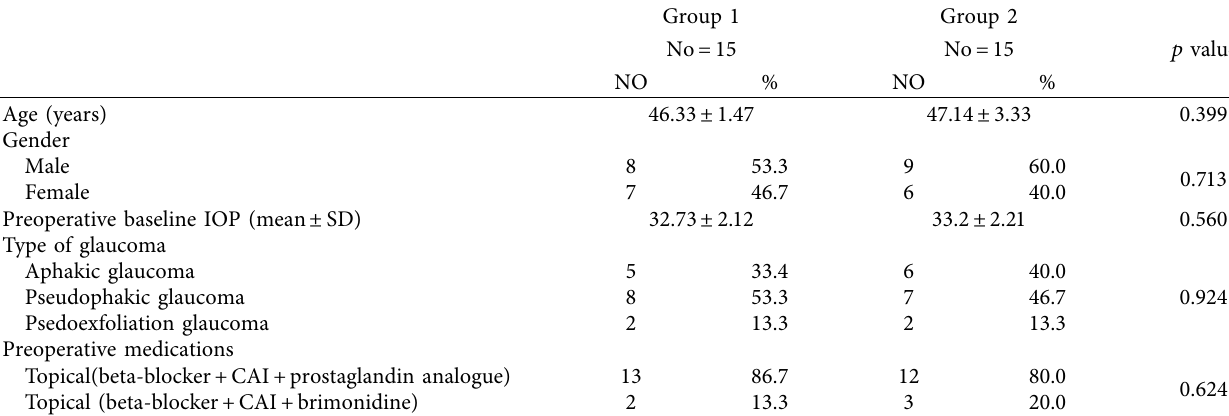
Table 1: Demographic data and baseline clinical data.